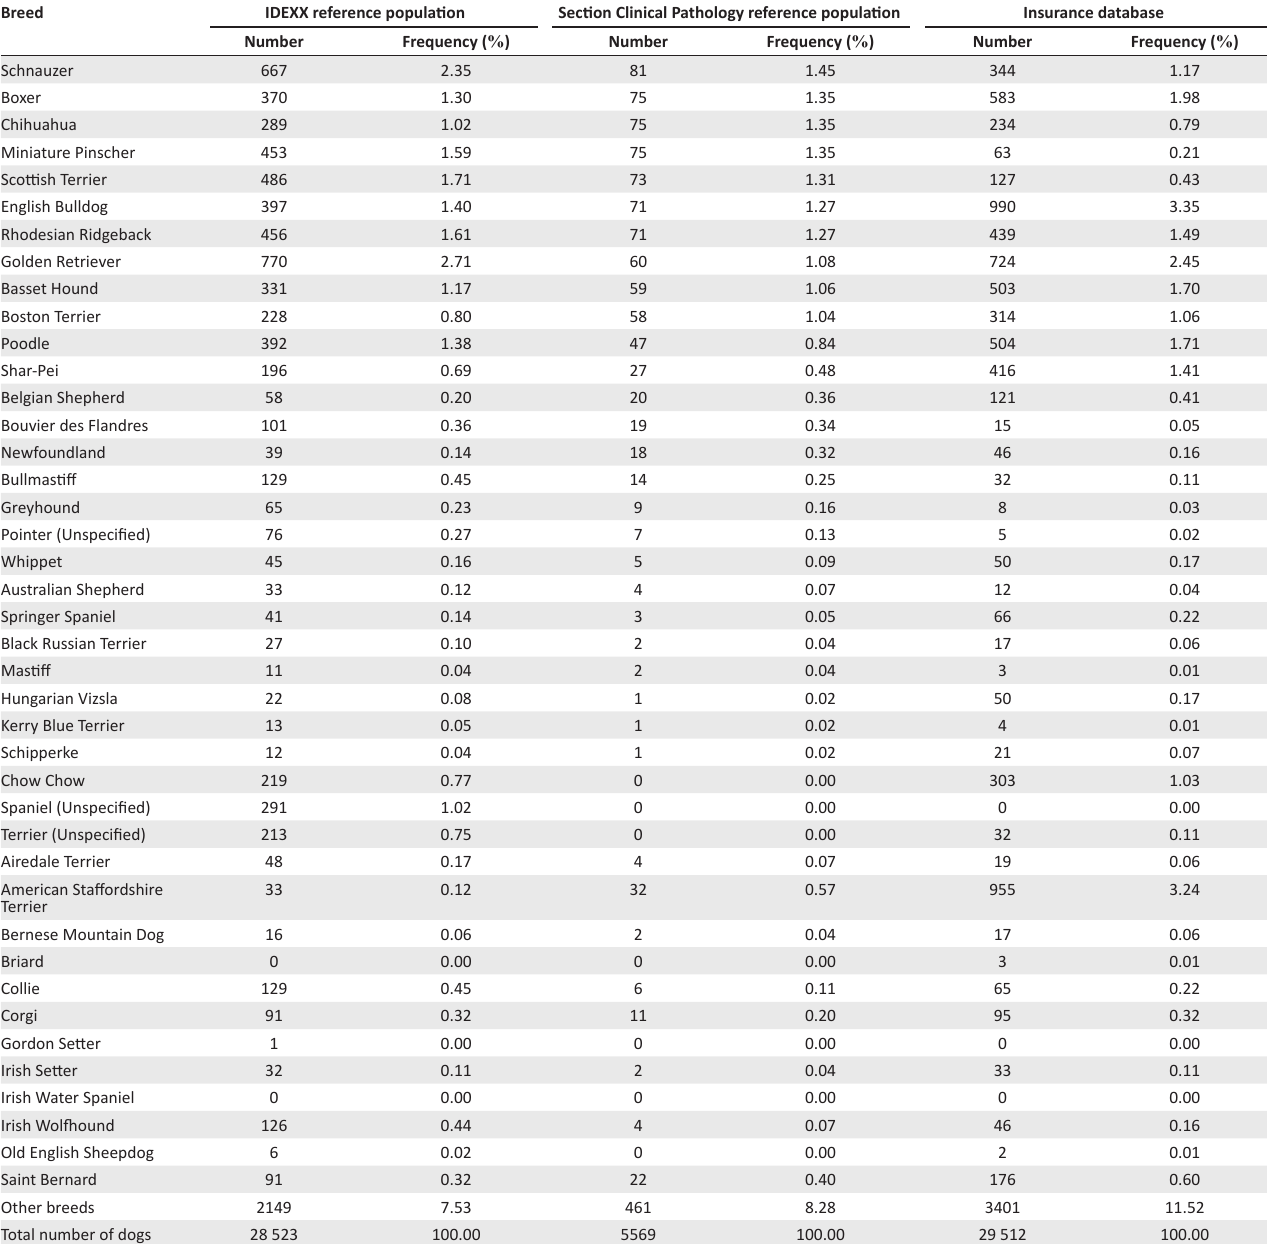
TABLE 1 (Continues...): List of dog breeds, as well as their absolute numbers and frequencies, in each reference population as well as in a pet insurance population.